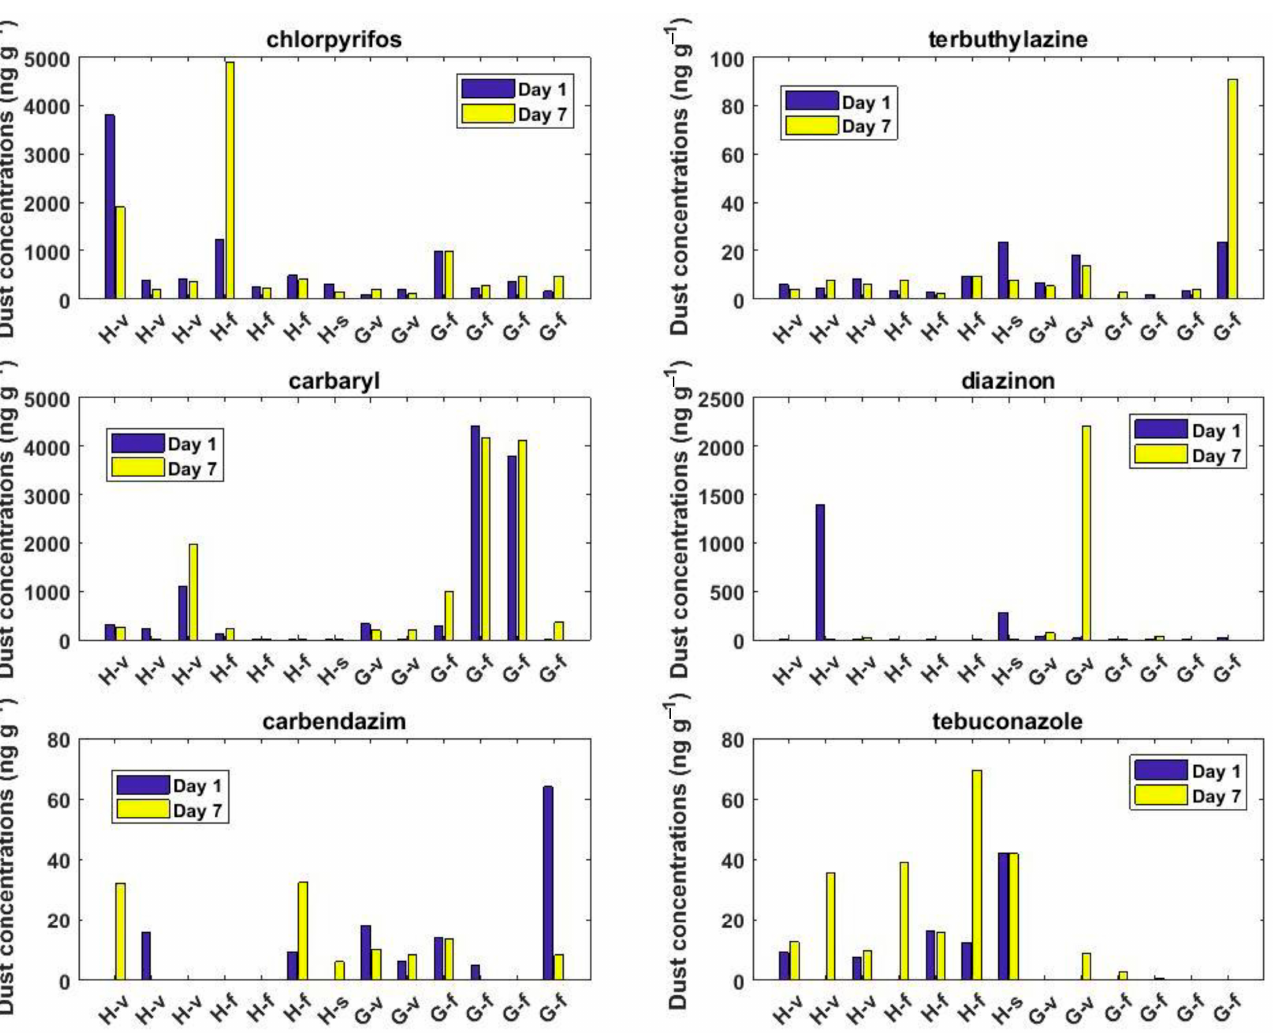
Figure 3. Temporal variations of pesticide levels in dust samples (in ng g − 1 ) collected at Hex River Valley (H) or Grabouw (G) at households living in farms (f), village (v), or at the school